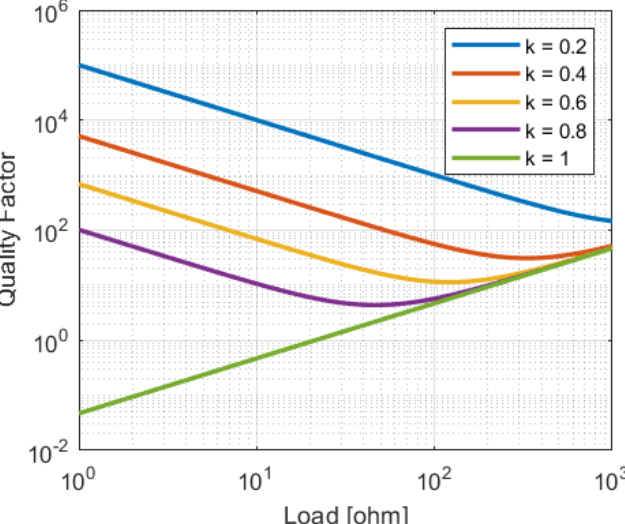
Figure 6. System Q for various loads and coupling factors (k). L = 500 nH and ω = 2 π · 13.56